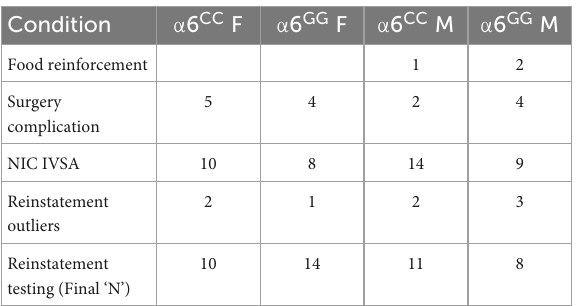
TABLE 1 Attrition rates for CHRNA 6 3 (cid:48) -UTR SNP rats in the